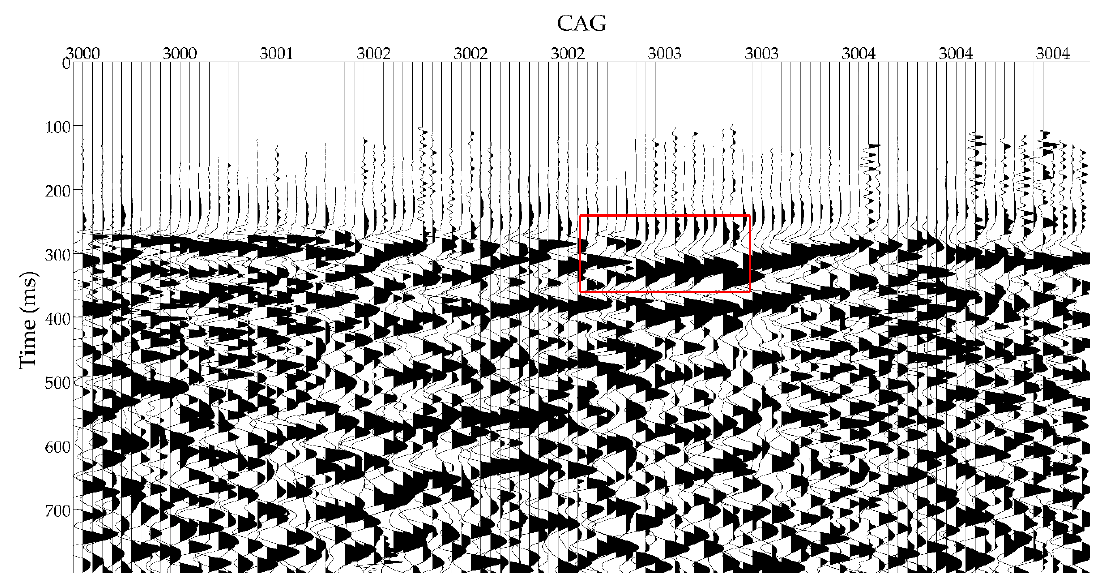
Figure 7. Common receiving-point gather (CRG) (No. 825) after static correction based on CRGs.